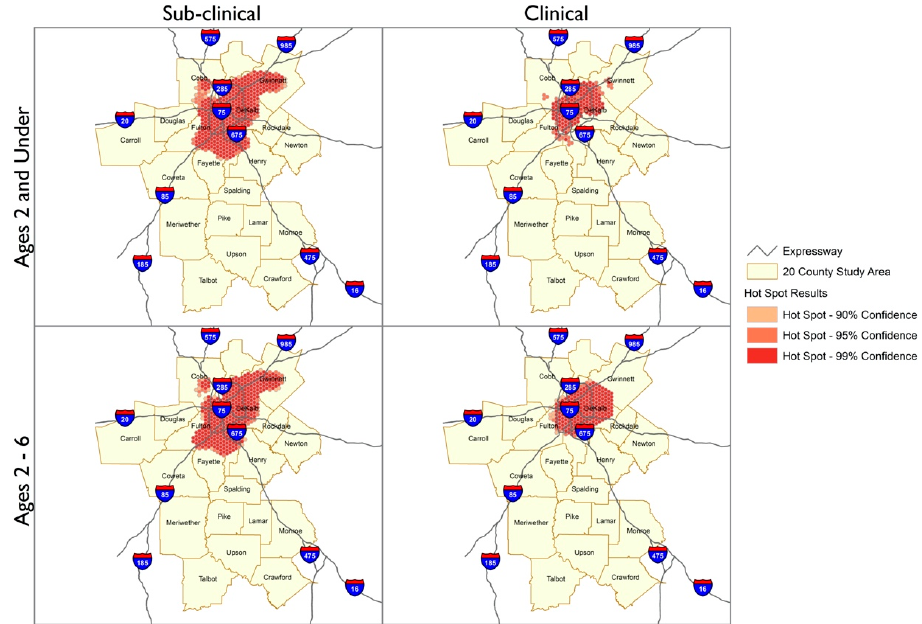
Figure 2. Comparison of Hotspot Analysis Distribution Patterns between Sub-clinical and Clinical BLLs for the year 2010. Hotspot analysis of the 90–99% confidence regions of hotspots for BLLs 2 to <5 µg/dL (Sub-clinical) and BLLs ≥ 5 µg/dL (Clinical) for 20-county metro Atlanta area in 2010. BLLs 2 to <5 µg/dL and BLLs ≥ 5 µg/dL are shown as red pattern dots with the darkest shaded regions reflecting the 99% confidence area.